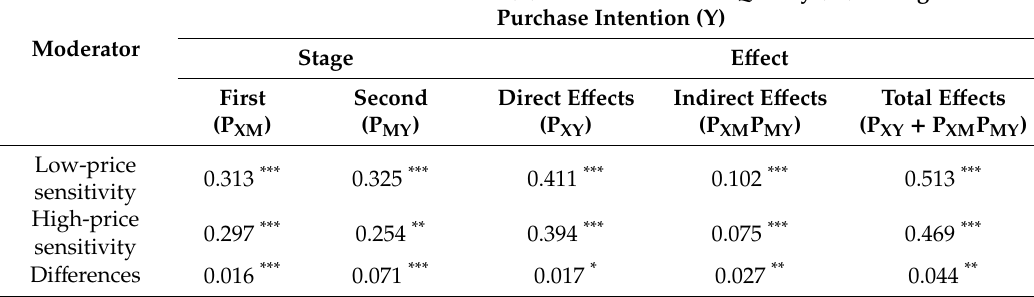
Table 6. Results of the moderated mediation path